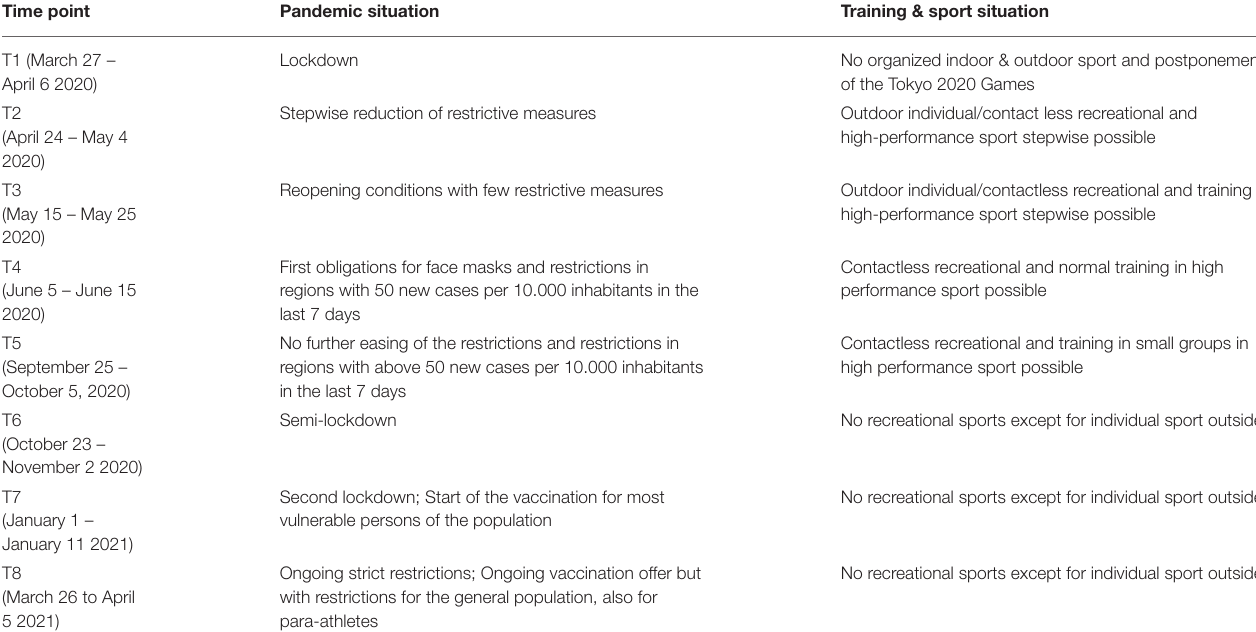
TABLE 1 | Measurement time points (T1-8) and the according pandemic situation in Germany (information of countermeasures was based on the following information: Presse- und Informationsamt der Bundesregierung). Time